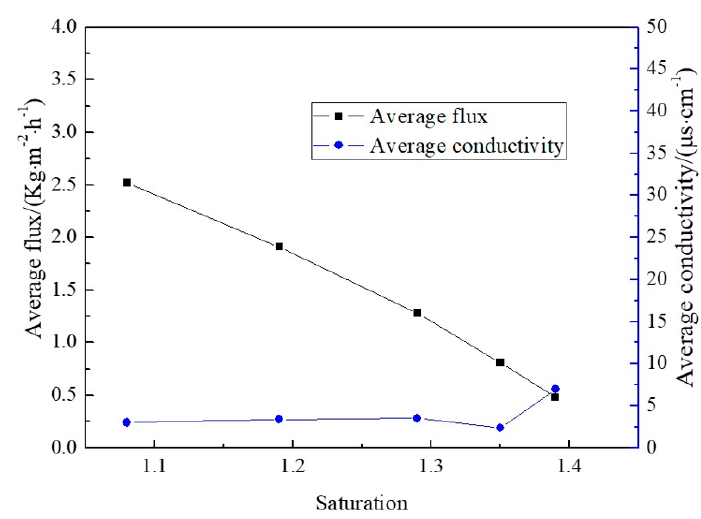
Figure 7. Evolution of flux and water yield conductivity during the preferential crystallization of NiSO 4 experiment.